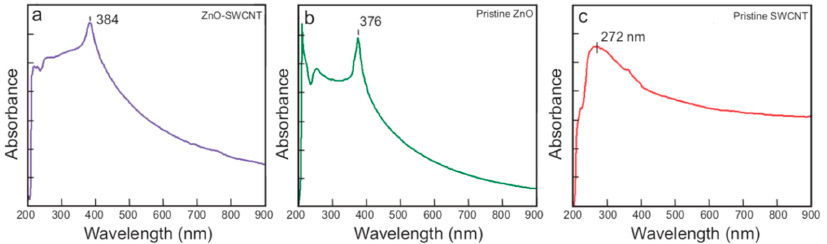
Figure 6. UV–vis absorption spectra of ( a ) a ZnO–SWCNT nanocomposite, ( b ) pristine ZnO nanorods, and ( c ) pristine SWCNTs.